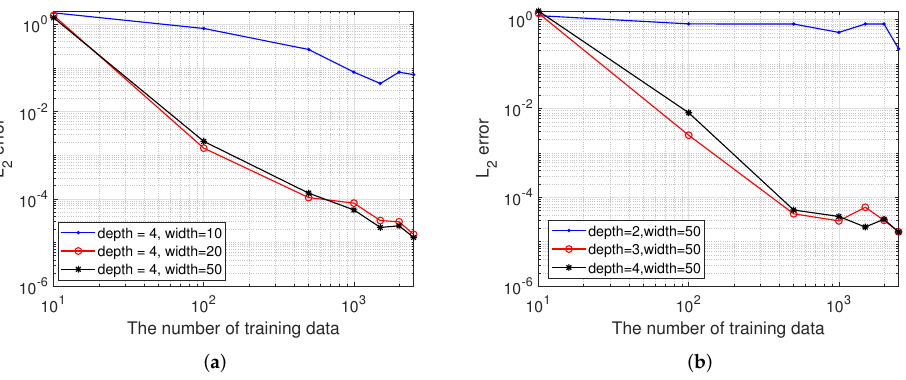
Figure 7. Example 3: Convergence results by using ( a ) different widths and ( b ) different depths.